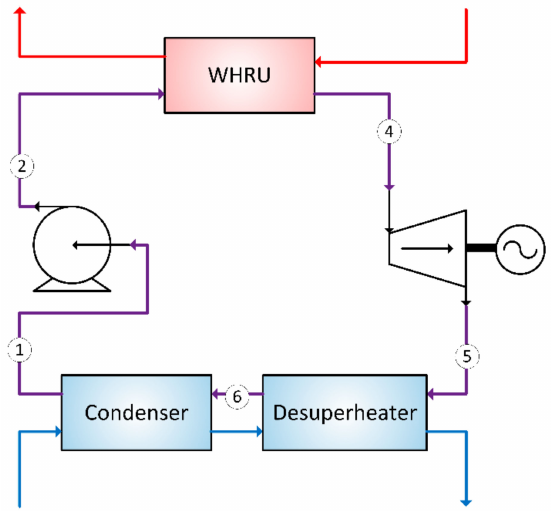
Figure 1. Process diagram of the organic Rankine cycle